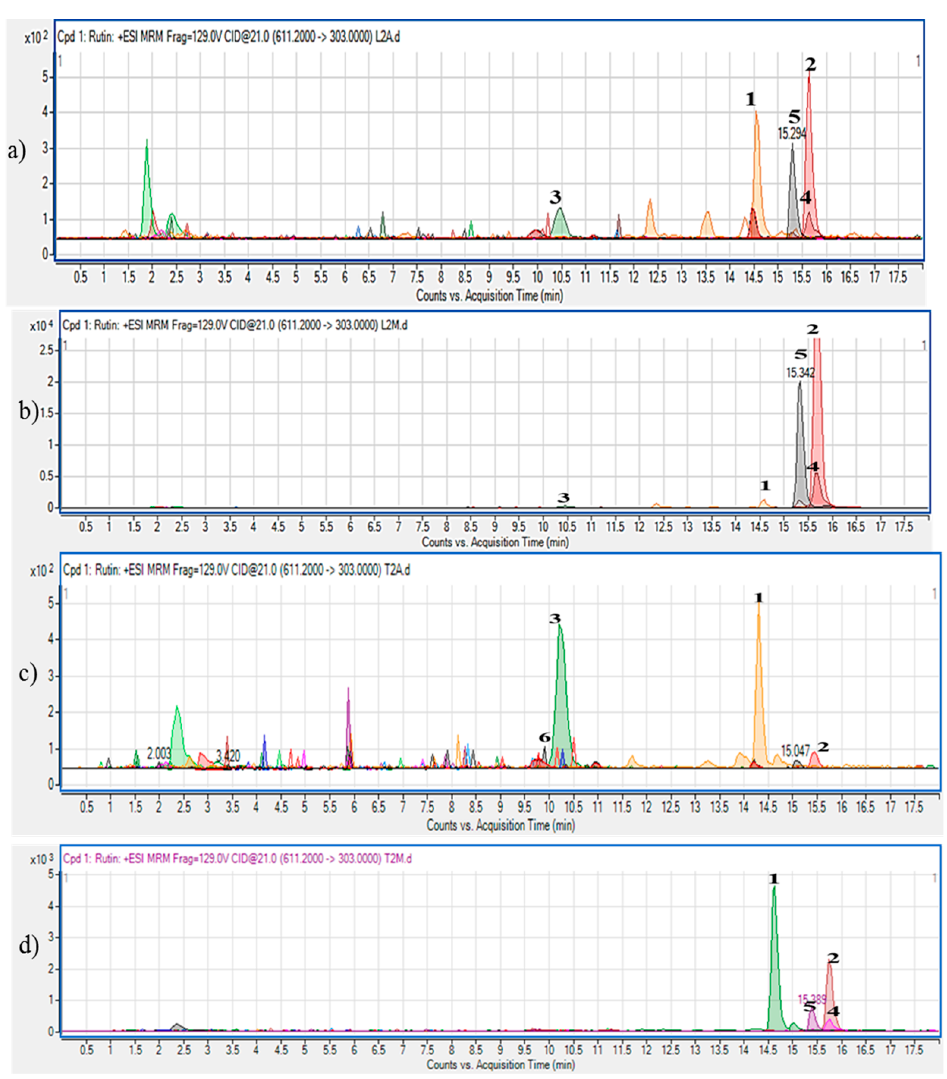
Figure 1. HPLC chromatograms of ( a ) aqueous extract of the leaves ( b ) aqueous-methanol extract of the leaves ( c ) Aqueous extract of the tubers ( d ) aqueous-methanol extracts of the tubers of orange